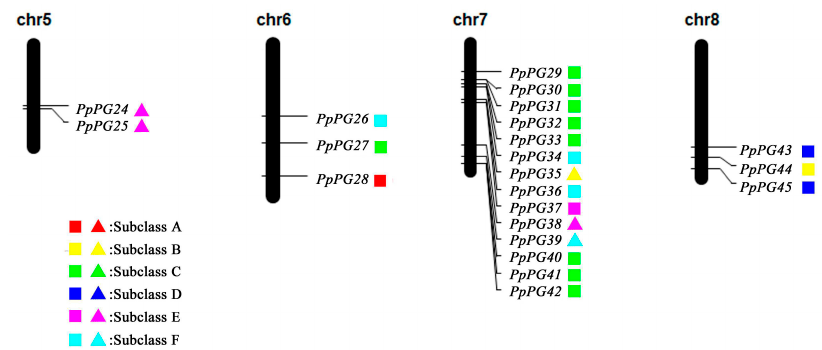
Figure 3. Chromosomal mapping of peach PG genes. Each subclass is shown by different color. Triangles, PpPG genes expressed in peach fruit; squares, PpPGs not expressed in peach fruit, according to results of RNA-seq.